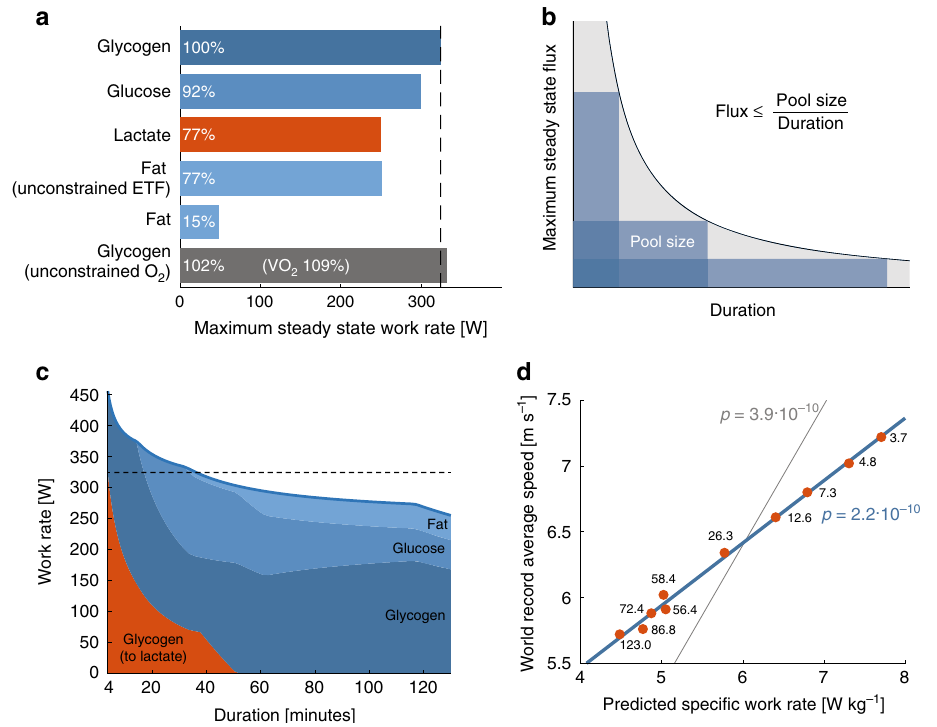
Fig. 5 Maximum work capacity on different substrates and at different durations. a There are differences in the maximum predicted work rate for different carbon sources, assuming unconstrained uptake. b The maximum steady-state fl ux is constrained by exercise duration, assuming substrates are depleted at the end of the exercise. c The maximum attainable work rate for a given exercise duration with maximum steady-state work rate (dashed line) for the reference. The colored regions show the relative fl ux of carbon on a carbon mol basis. d The decrease in running speed at increasing distances may largely be explained by limited metabolite pool sizes. There is a linear relation between the predicted maximum speci fi c work rate (predicted work rate per kg bodyweight) at different durations and the world-record average running speeds at these durations (3.7 – 123 min), regression without intercept (gray line) and with intercept (blue line), p -value from the t -statistic of the